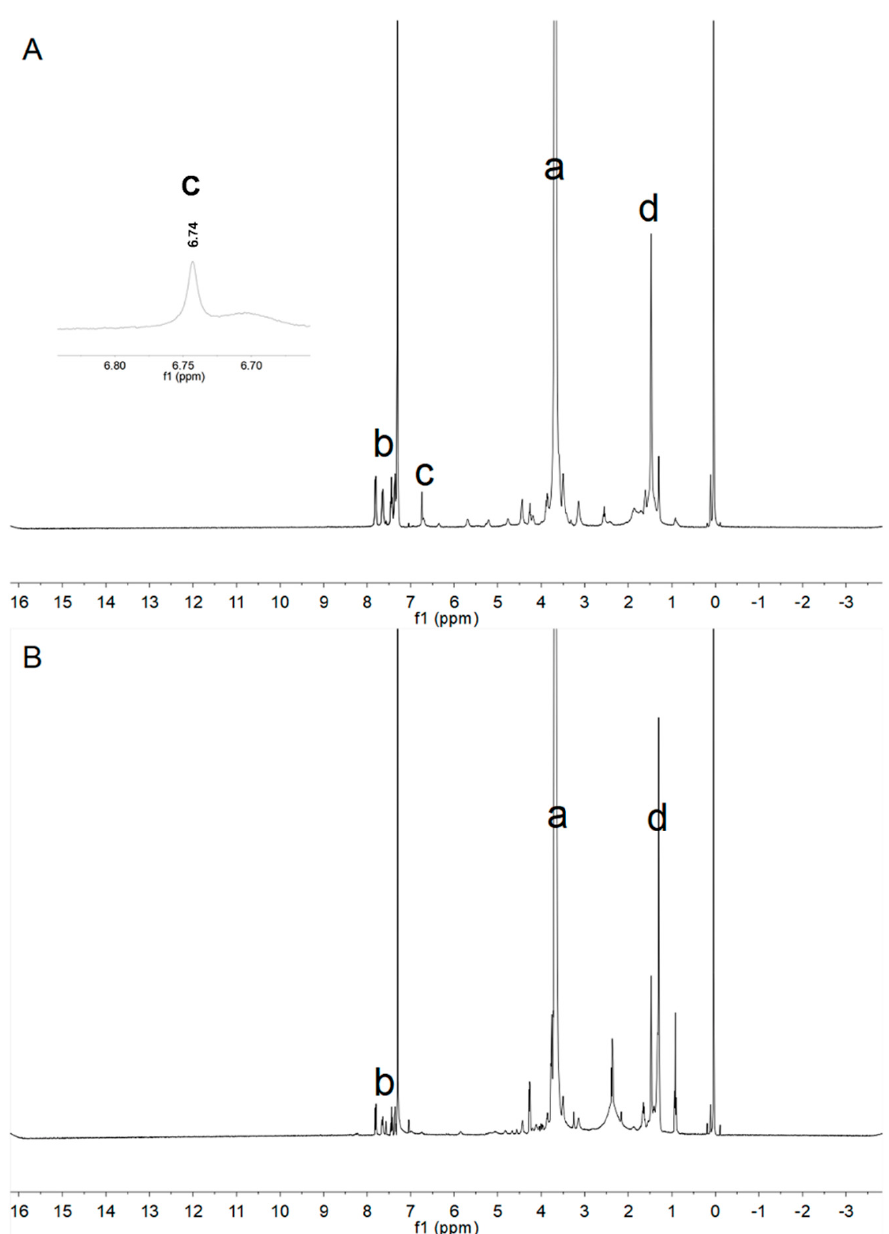
Figure 1. Determination results of Fmoc-Lys-PEG and Fmoc-Lys-PEG-RGD. ( A ) 1 H-NMR spectra of Fmoc-Lys-PEG. ( B ) 1 H-NMR spectra of Fmoc-Lys-PEG-RGD. a: 3.5–3.8 ppm, PEG; b: 7.0–7.3 ppm, Fmoc; c: 6.7 ppm, Mal; d: 1–2 ppm, Boc.